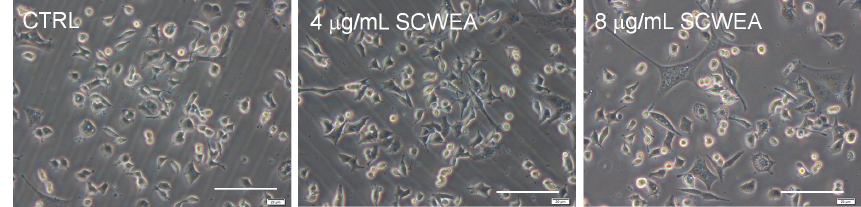
Figure A1. The regulatory effects of SCWEA on the morphology of PC12 cells. PC12 cells were exposed to 4 and 8 µg/mL SCWEA for 24 h and the morphologies were detected via microphotograph. 10×, scale bar: 50 µm.